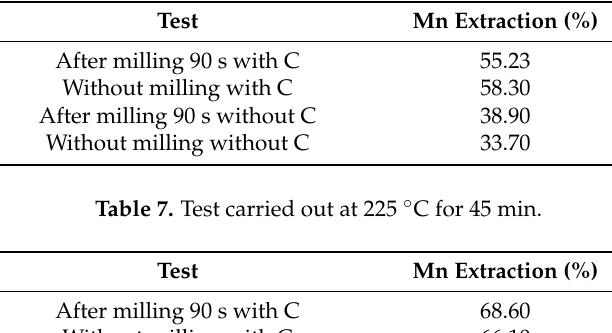
Table 6. Test carried out at 200 ◦ C for 60 min.